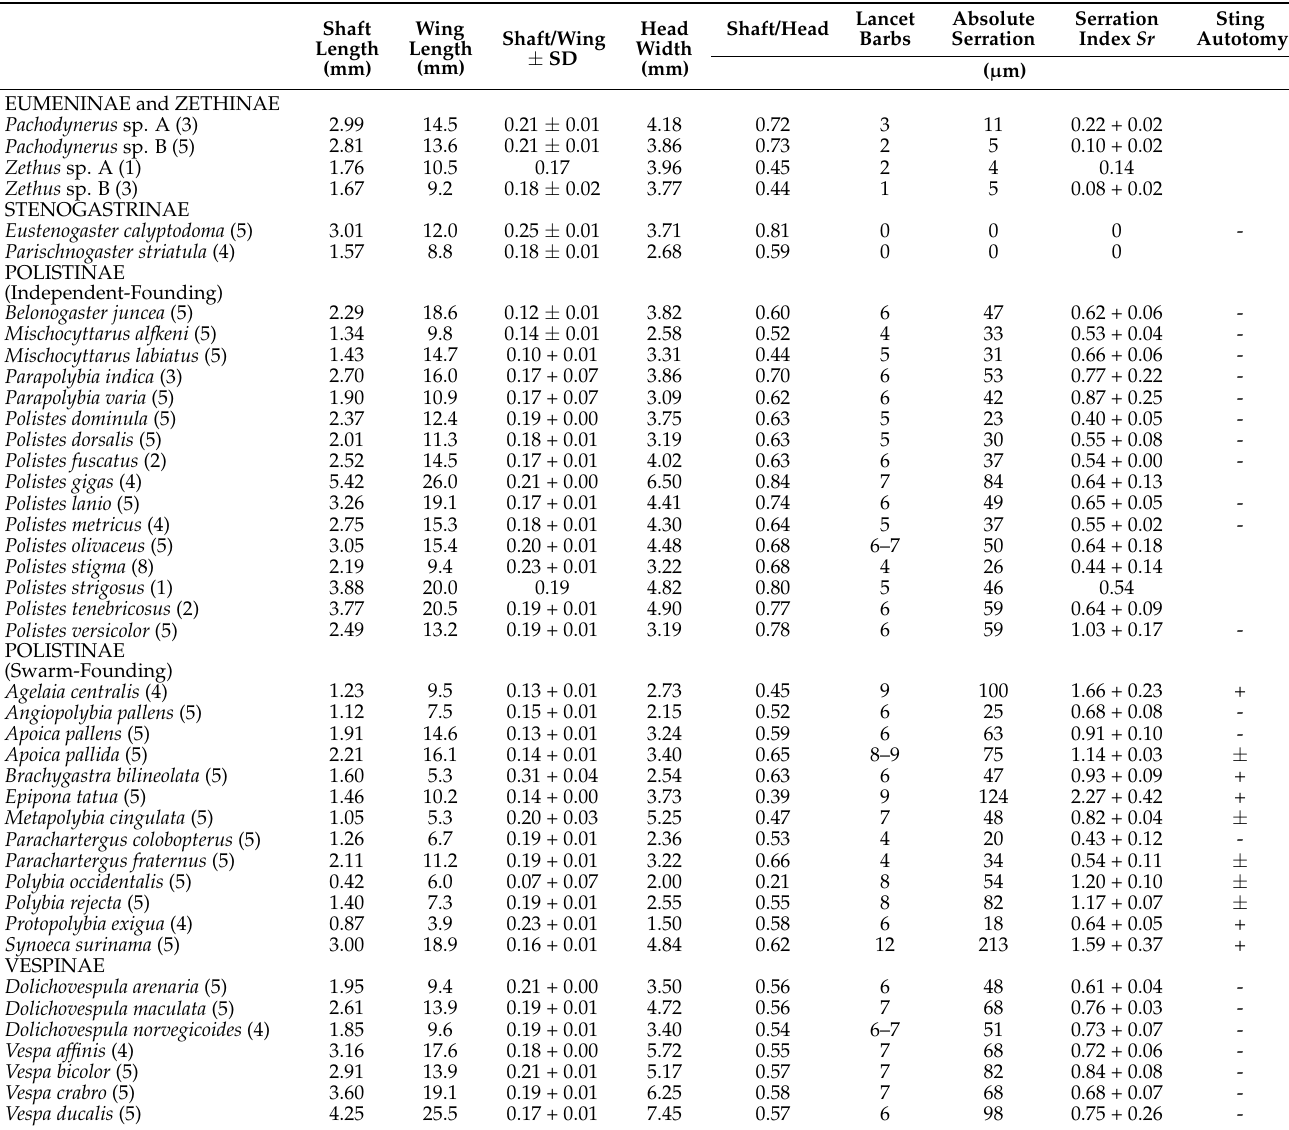
Table 1. Features of the stinger in vespid wasps and the honey bee Apis mellifera . In the Vespinae and Apis mellifera , all specimens are apparent workers. The bracketed number after each species name is the sample size. All figures are means, except number of barbs, which is the mode. Only barbs forming an acute angle proximally are counted. Absolute serration is the summed depths of all barbs, while the serration index is the ratio of absolute serration to the height of the sting lancet. Sting autotomy in human skin is coded as almost never ( − ), often ( ± ), or usually (+) occurring according to literature reports and many personal communications; signs in square brackets are inferred from closely related